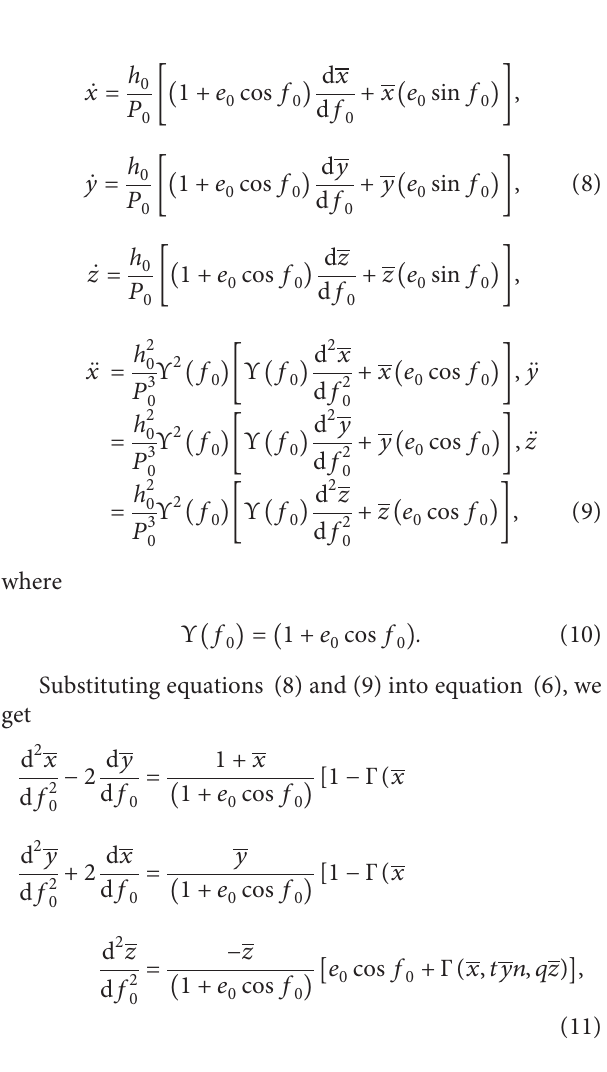
Figure 1: Configuration of the LVLH